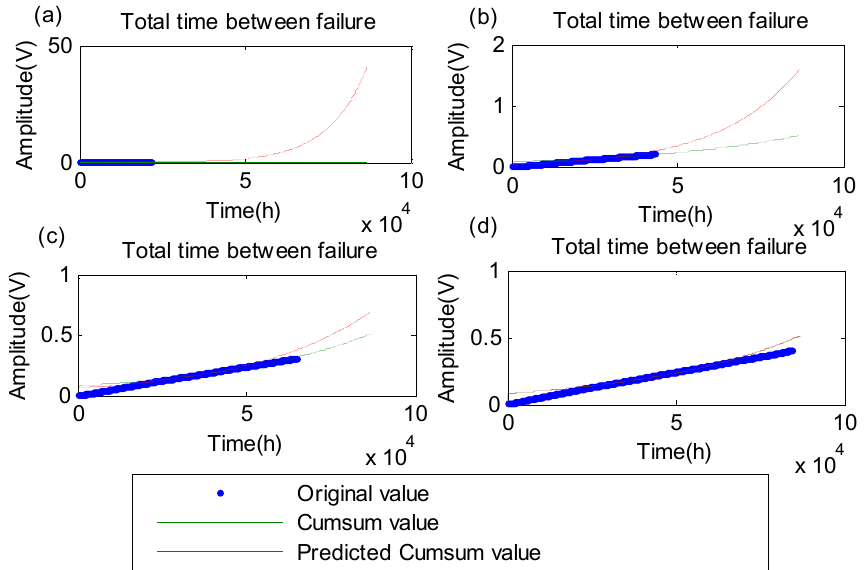
Figure 10. The RUL prognostics results with kurtosis of the accumulative signal utilizing grey theory: ( a ) prognostics result based on 25% of the accumulative data; ( b ) prognostics result based on 50% of the accumulative data; ( c ) prognostics result based on 75% of the accumulative data; ( d ) prognostics result based on 100% of the accumulative